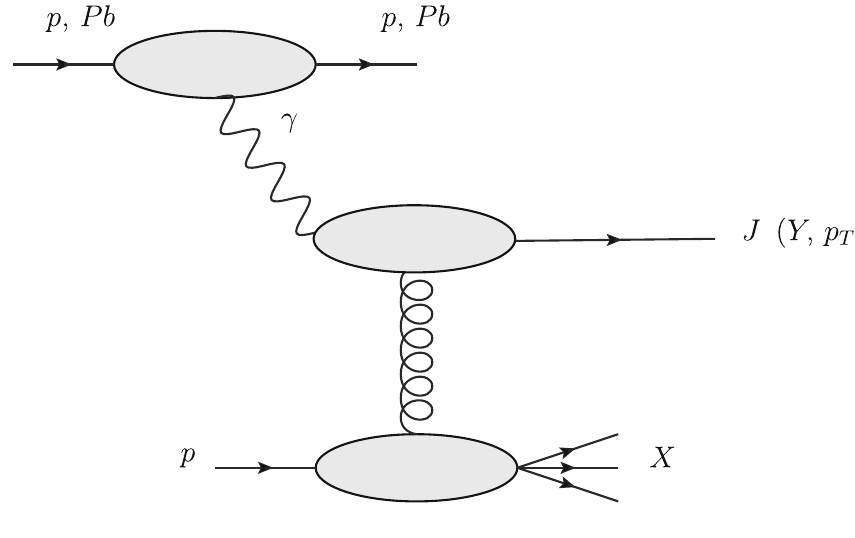
Fig. 1 Typical diagram for the single inclusive jet photoproduction in a hadronic